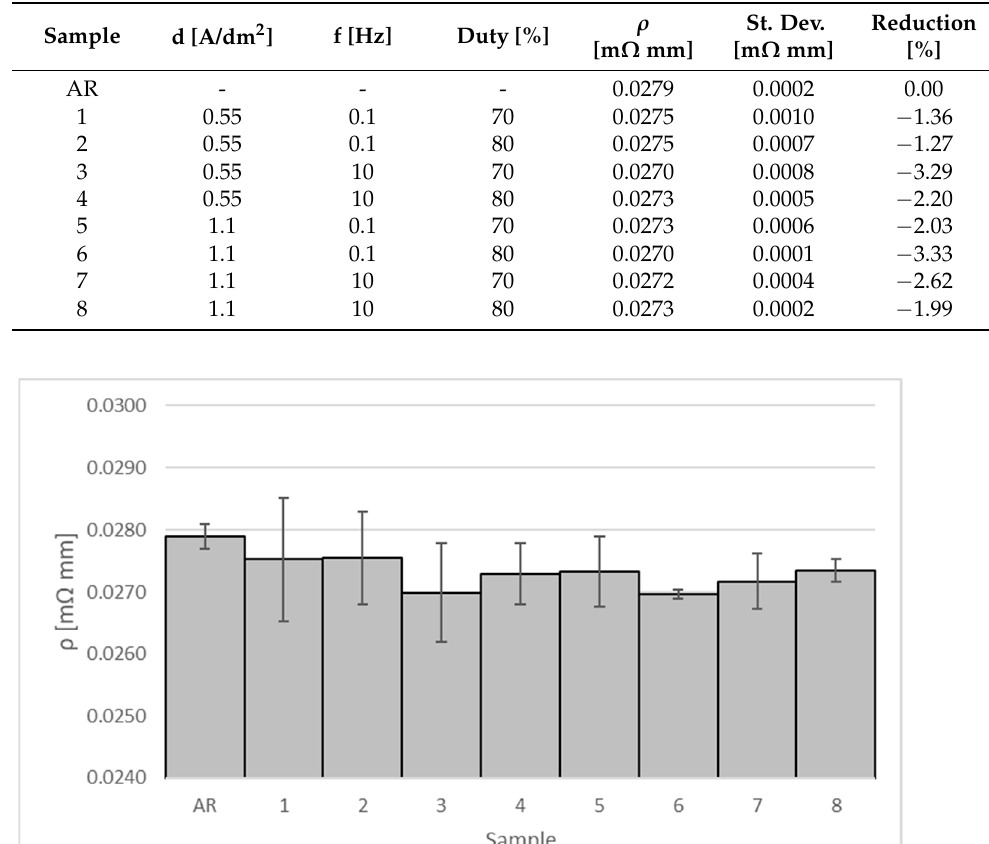
Table 8. Electric resistivity of the coated samples and their percentage reduction compared to the as-received one (AR).